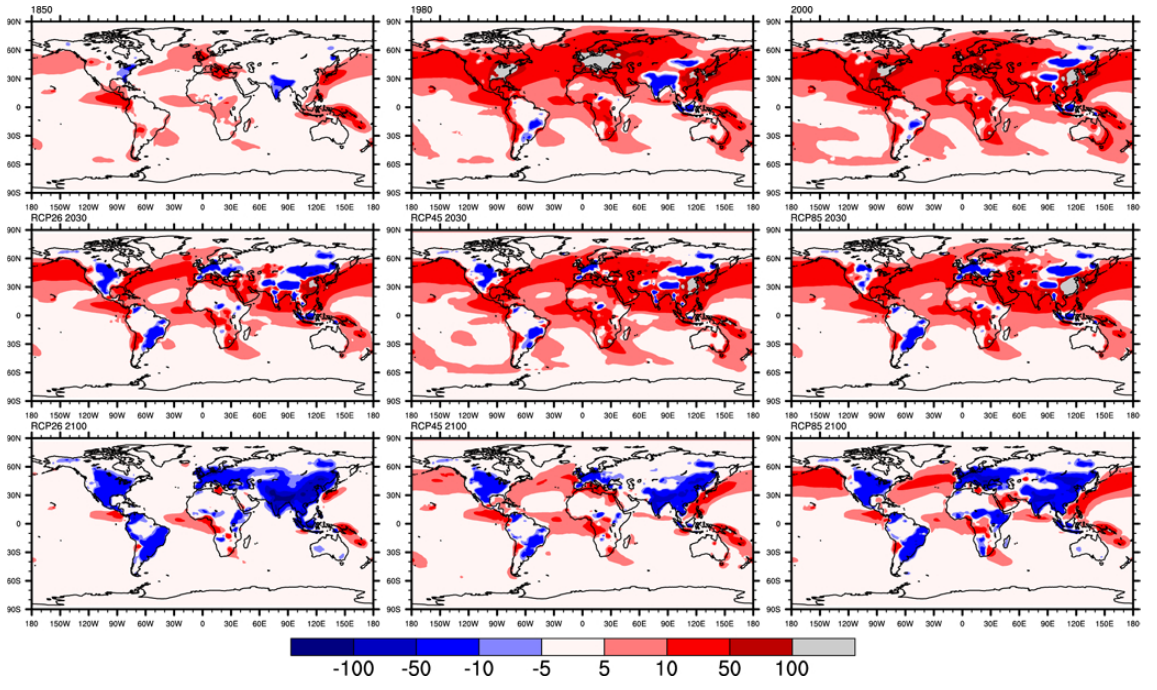
Fig. 6. Time evolution of added deposition acidity (10 − 6 molm − 2 yr − 1 ) computed as 2 · SO x + NO y − NH x . Blue regions indicate areas where deposition is more basic than it would have been without those respective emissions. Top row shows 1850, 1980 and 2000. Middle row shows 2030 for RCP2.6, RCP4.5 and RCP8.5. Bottom row shows 2100 for RCP2.6, RCP4.5 and